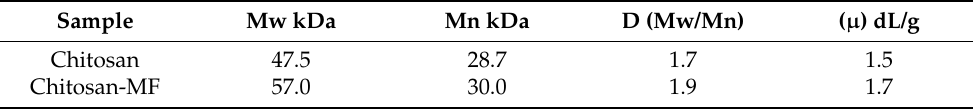
Table 2. Main results of the HP-SEC-TDA analysis for the chitosan and chitosan-MF samples.